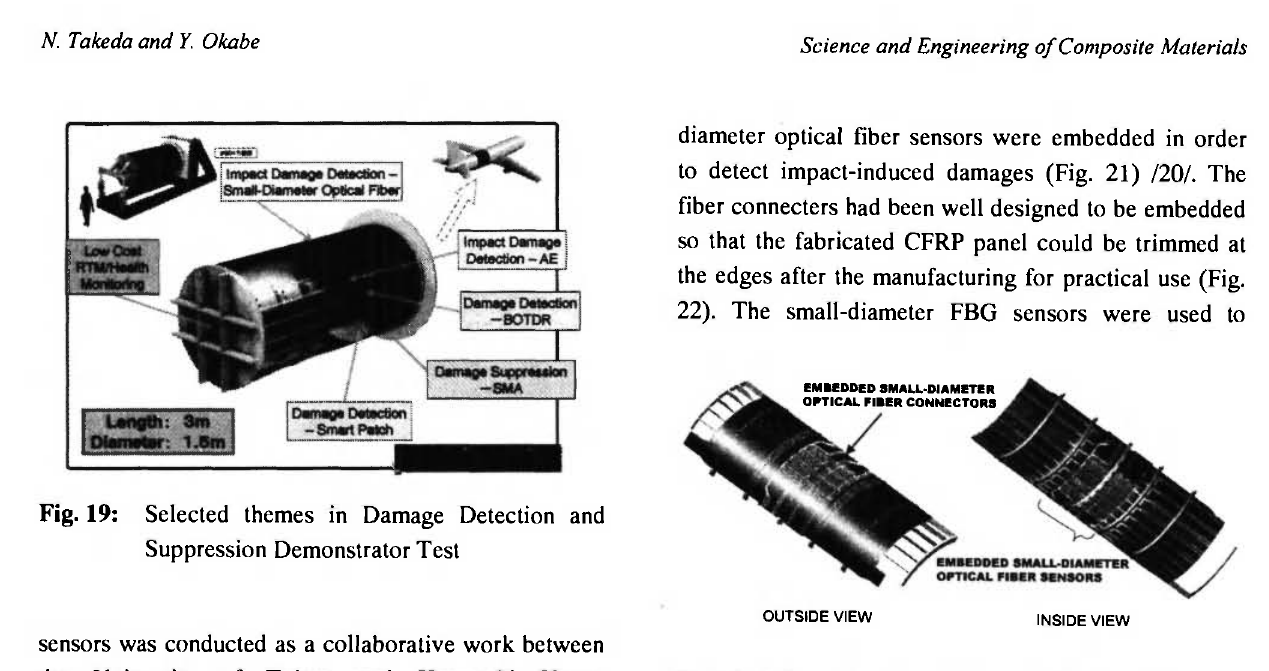
Fig. 19: Selected themes in Damage Detection and Suppression Demonstrator Test